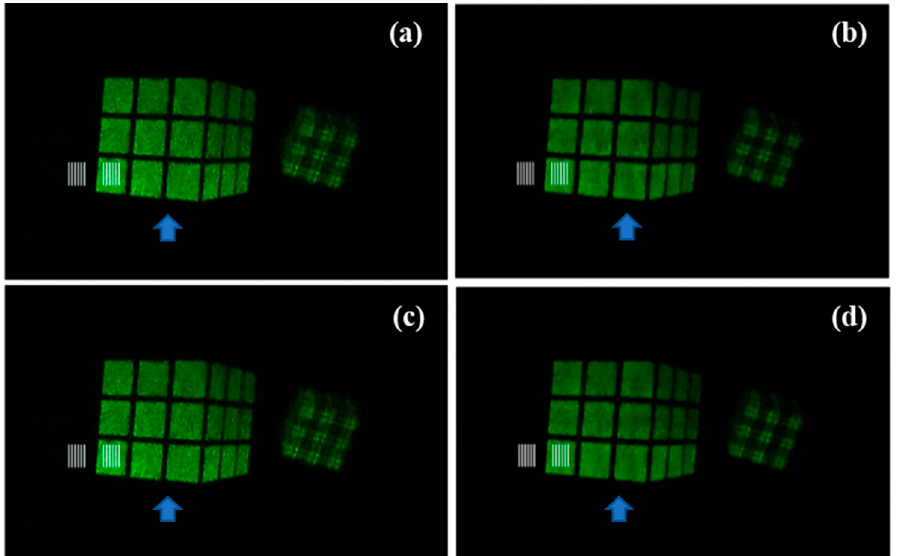
Figure 9. Experimental optical observations reconstructed from each hologram in the case of CAO encoding ( a ), MAO encoding ( b ), Burckhardt’s encoding ( c ), and Lee’s encoding ( d ) where the eye of the observer is focused on the fore-positioned object. Each arrow indicates the focused object between a pair of 3D objects in a camera-captured image from optically reconstructed H3D scenes (716 × 450 pixels). Here, each scanned area (27 × 38 pixels) appears in the shape of multiple lines in white color near the front-positioned 3D cube [see also the Supplementary video (a)~(d)].